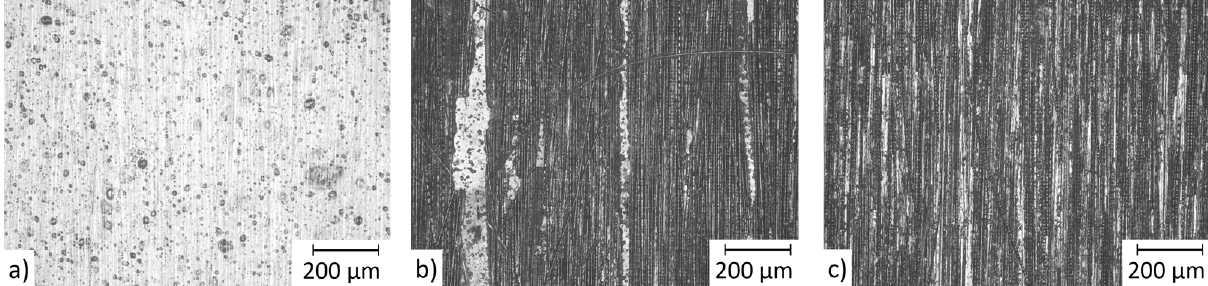
Figure 4. Optical microscope images of three surface qualities after laser pre-treatment with ( a ) insufficient, ( b ) optimal, and ( c ) damaging material removal.